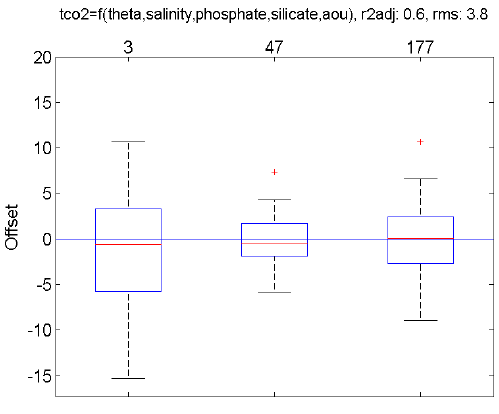
Figure 3. MLR results for TCO 2 in the Canada Basin (o ff sets in µ molkg − 1 ). The figure contains the predictor function at the top, followed by the adjusted R 2 -value and the root mean square error. The boxes contain lines at the median and upper and lower quartiles. The whiskers extend 1.5 times the interquartile range of the sample. Values outside the whiskers are considered outliers and are marked by red + .